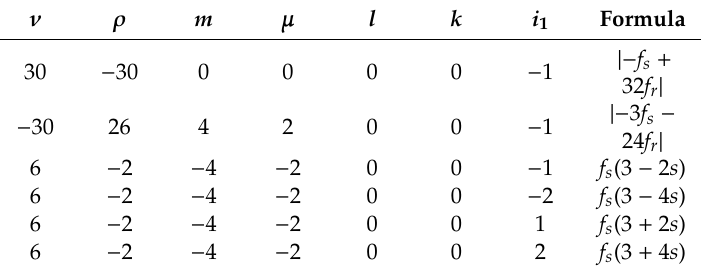
Table 7. Harmonic orders and formulas for the broken rotor